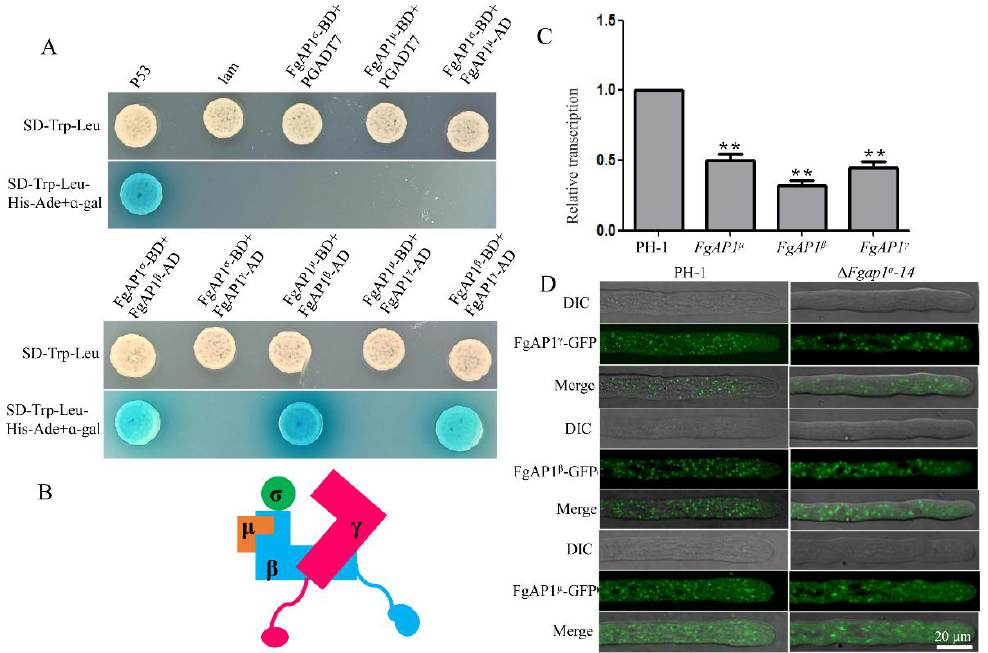
Figure 7. The relationship between FgAP1 complex subunits and the localizations of the various subunits in ∆ Fgap1 σ mutant. ( A ) Yeast two-hybrid assay showing the interactions of the AP1 complex subunits. There were positive interactions between FgAP1 β and FgAP1 σ and between FgAP1 γ and FgAP1 μ . The interaction between pGBKT7-Lam and pGADT7-T was used as a negative control while that between pGBKT7-53 and pGADT7-T served as a positive control. ( B ) The interaction model of FgAP1 σ with the other subunits of FgAP1 complex. FgAP1 σ interacts with FgAP1 β , and FgAP1 β interacts with FgAP1 γ and FgAP1 μ , which indicates that FgAP1 σ , FgAP1 β , FgAP1 γ , and FgAP1 μ function as a complex in F. graminearum . ( C ) The expression levels of FgAP1 β , FgAP1 γ , and FgAP1 μ were significantly downregulated in ΔFgap1 σ mutant. Level of significance was measured using an unpaired t -test (** p < 0.01). ( D ) The localizations of FgAP1 β -GFP, FgAP1 γ -GFP, and FgAP1 μ - GFP were not affected in ΔFgap1 σ mutant. Bar = 20 μm.